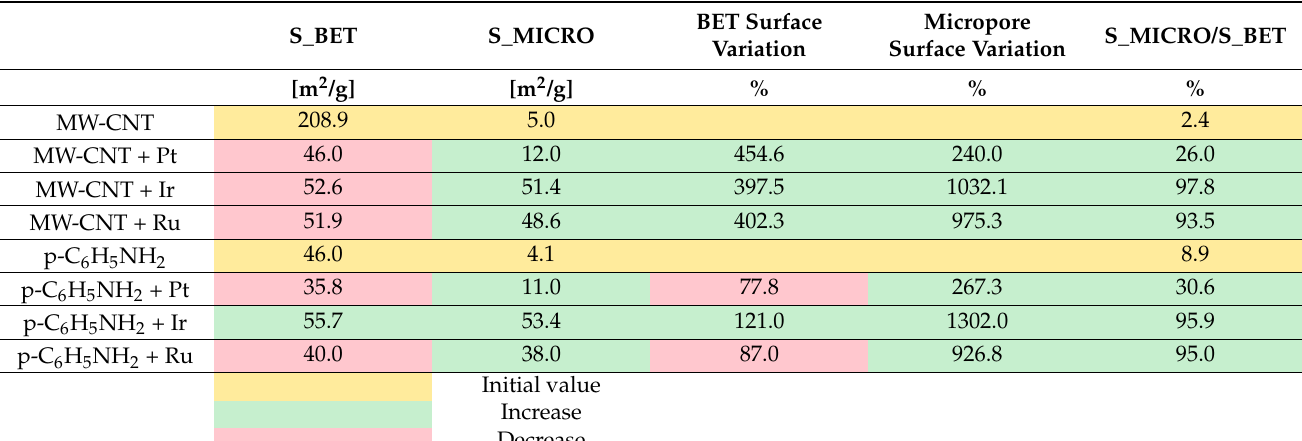
Figure 4. BET plots for the doped and undoped p-C 6 H 5 NH 2 . Table 1. Numerical values for BET and micropore